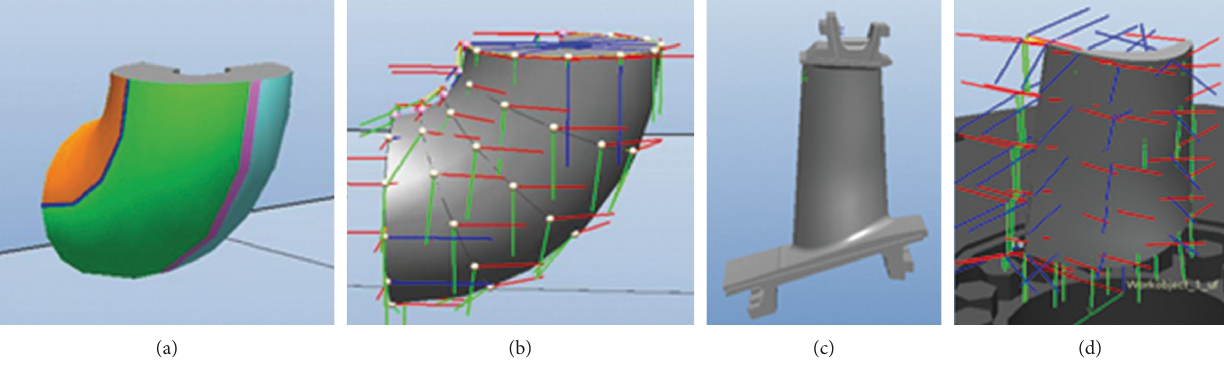
Figure 14: Autogeneration of trajectory on free-form surfaces.